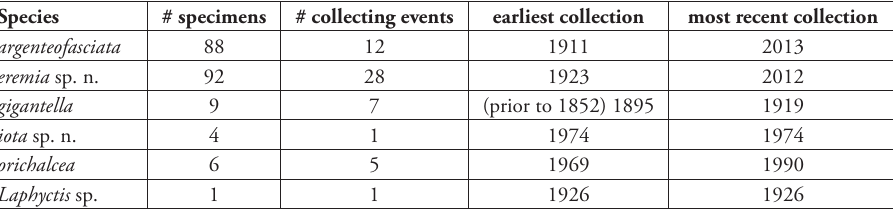
Table 1. Collecting event summary for Laphyctis species. The holotype of L. gigantella has no collecting year and was collected prior to 1852. Species earliest collection